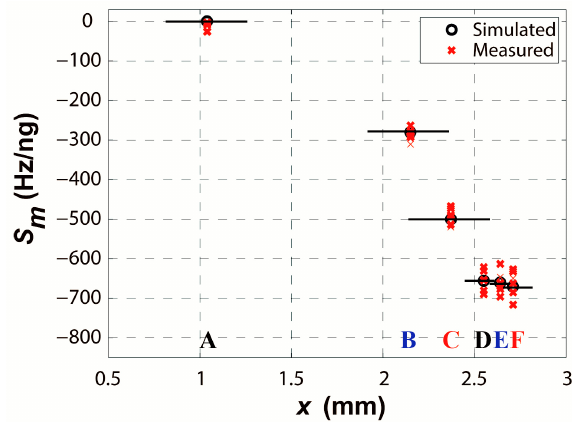
Figure 17. The simulated and measured mass sensitivity for different surface areas, each position being demonstrated by repeated measurements.